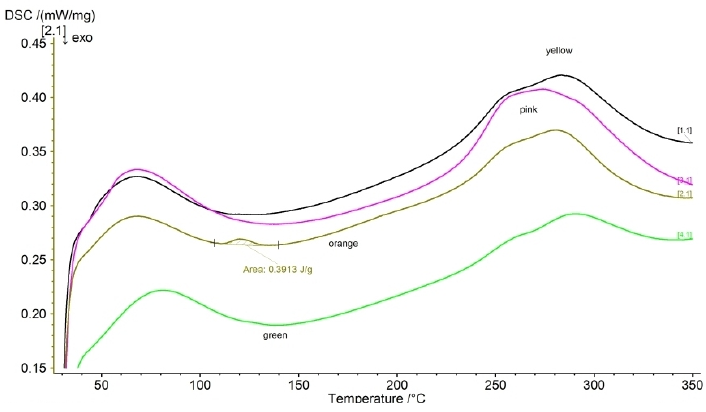
Figure 10. The DSC curves.